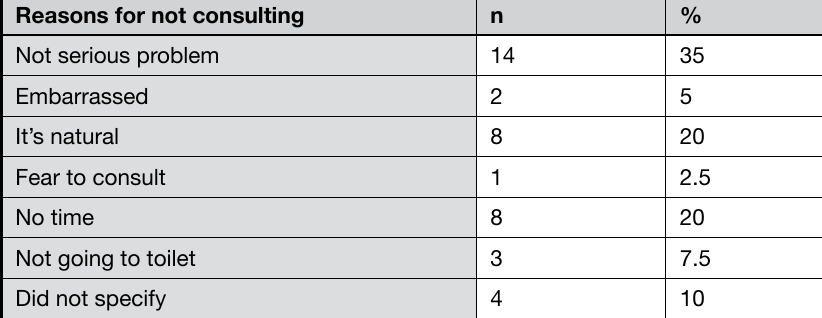
Table 4: Reasons for not seeking medical intervention (n = 46) Reasons for not consulting n % Not serious